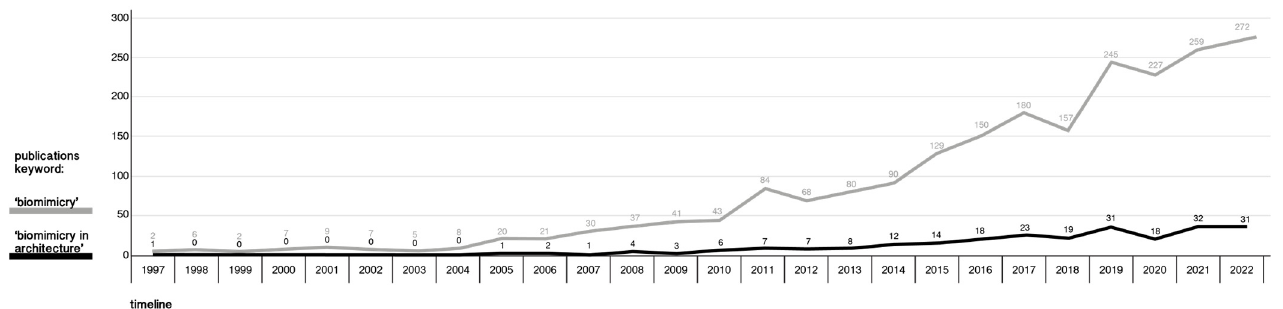
Figure 1. Publications (Scopus) on the topic of biomimicry using the keywords ‘biomimicry in architecture’ (black) and ‘biomimicry’ (grey), from 1997 to 2022.